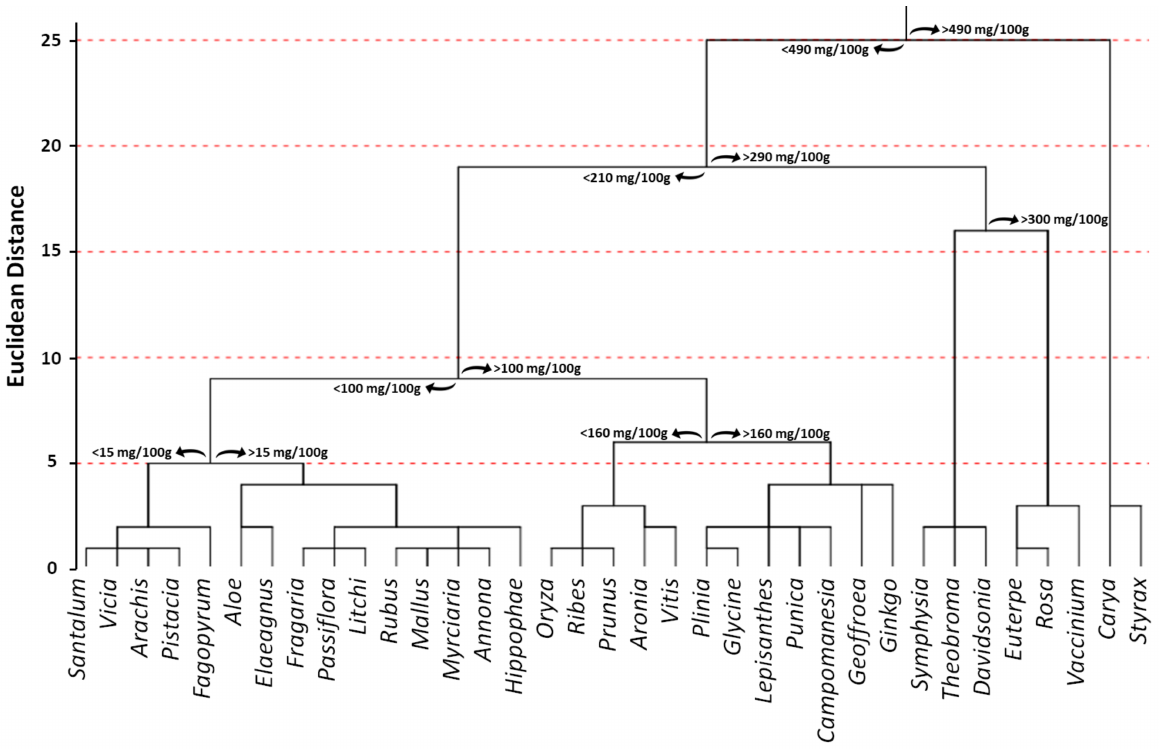
Figure 12. Cluster distribution of proanthocyanidins based on the total proanthocyanidin content within plant families and according to previously published data [96,97,99–102,104,105,116–148]. Euclidean distances were calculated with the average linkage method. Statistical analysis and graphical representation were made using SPSS v. 24 software.